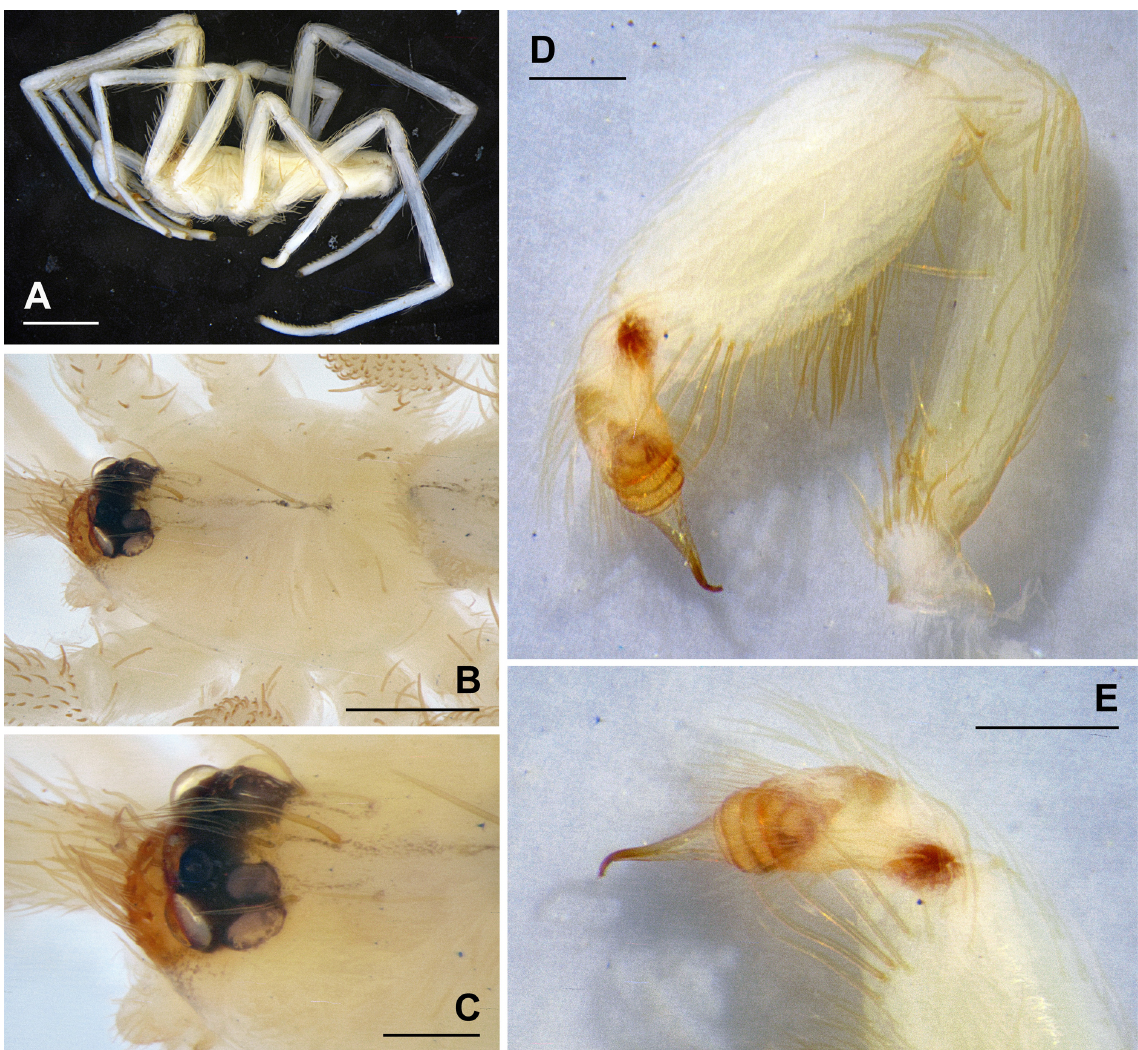
Fig. 37. Somatic characters and palp of Zaitunia maracandica (Charitonov, 1946), ♂ from Ulus. A . Habitus, lateral. B–C . Prosoma, laterodorsal. D–E . Palp, retro- and prolateral. Scale bars: a = 1.0 mm; B = 0.5 mm; C–e = 0.2